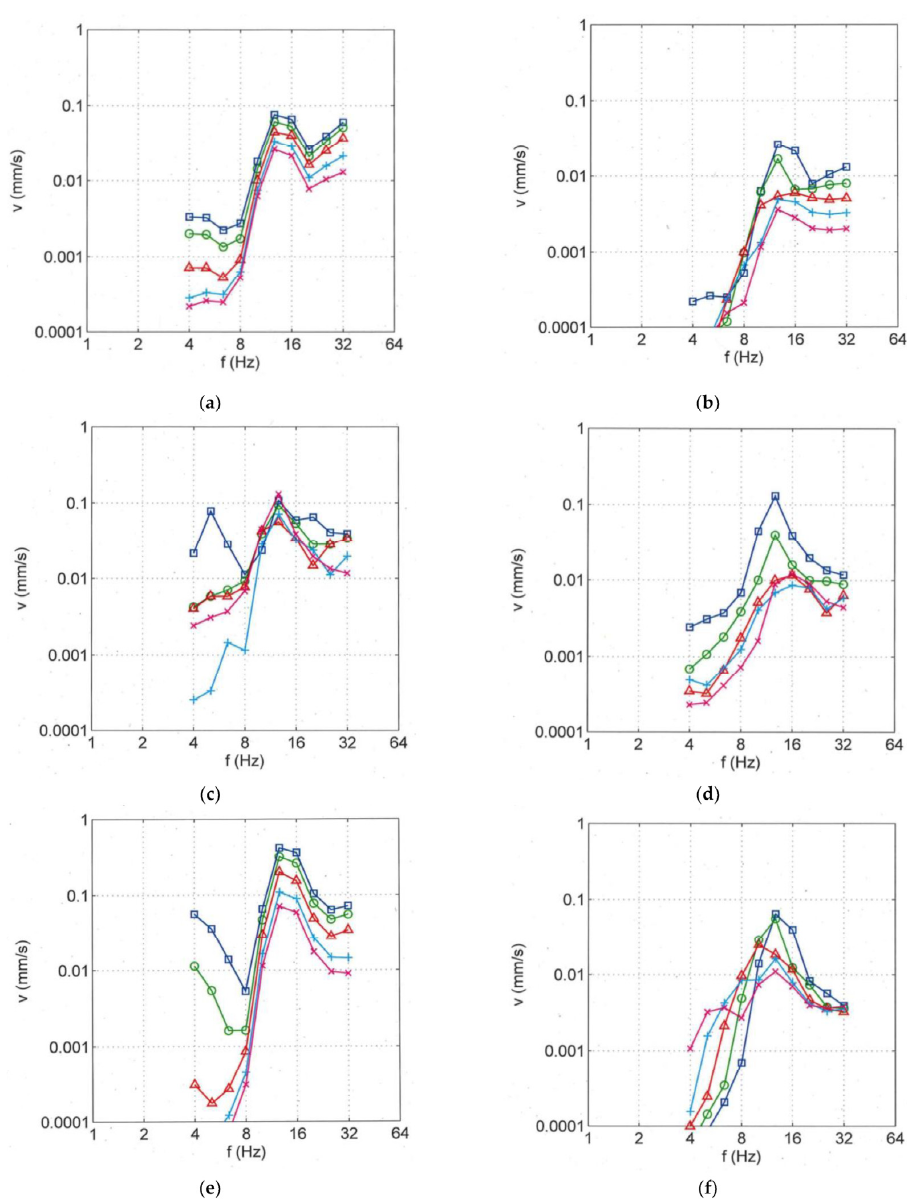
Figure 10. Comparison of measured and calculated ground vibrations; wavefield at distances x = □ 3, ○ 5, ∆ 10, + 20, × 30 m for the maximum train speed of 160 km/h ( a , c , e ), and for different train speeds of v T = □ 160, ○ 125, ∆ 100, + 80, × 63 km/h at a distance of 30 m ( b , d , f ), calculated with geometric track irregularities ( a , b ), measured at site W ( c , d ), and calculated by a varying track support stiffness ( e , f ).